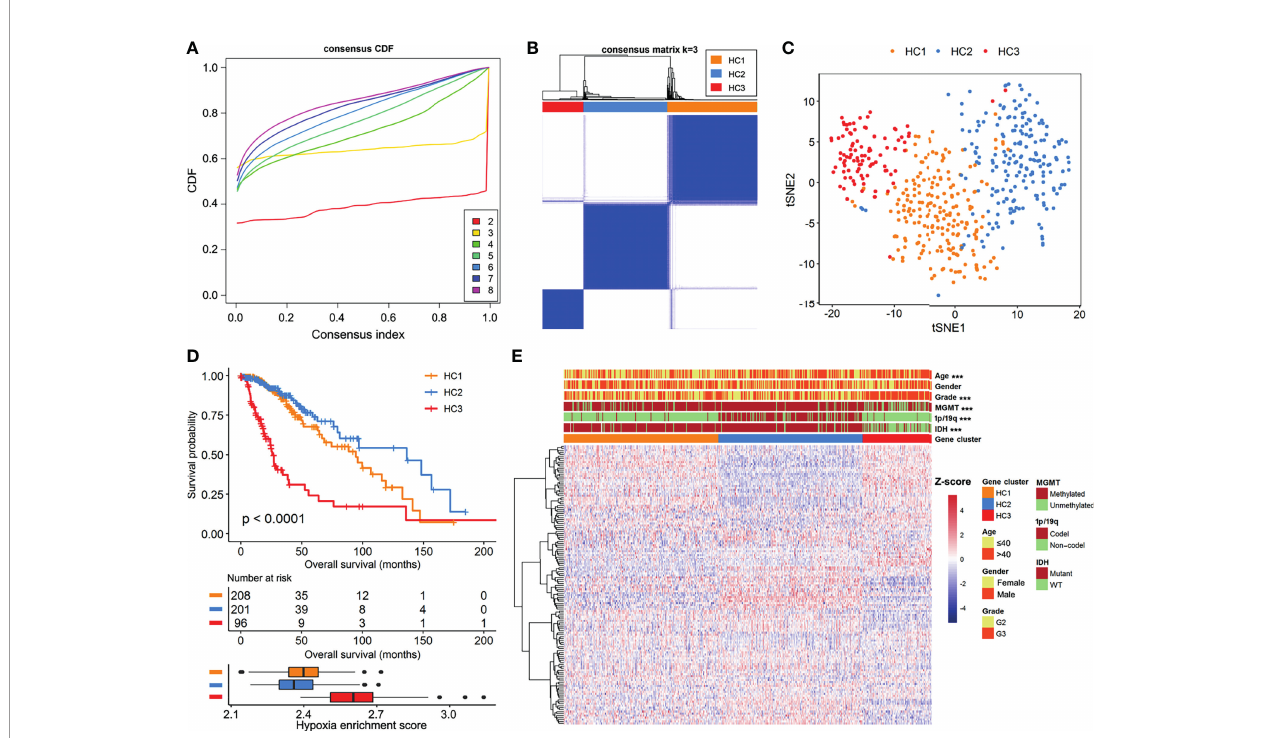
FIGURE 1 | Identi fi cation of hypoxia-related subtypes in the TCGA-LGG cohort. (A) Cumulative distribution function (CDF) curves for k=2 to k=8. (B) Heatmap of consensus clustering matrix at k=3. (C) The classi fi cation into three subtypes validated by t-SNE analysis in the TCGA-LGG cohort. (D) Survival curves and hypoxia enrichment scores for the three hypoxia subtypes. (E) Heatmap of hypoxia-related mRNAs and clinicopathologic information across the three hypoxia